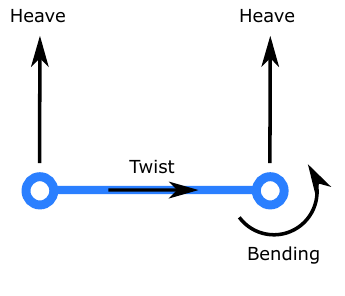
Figure 9. Euler-Bernoulli beam